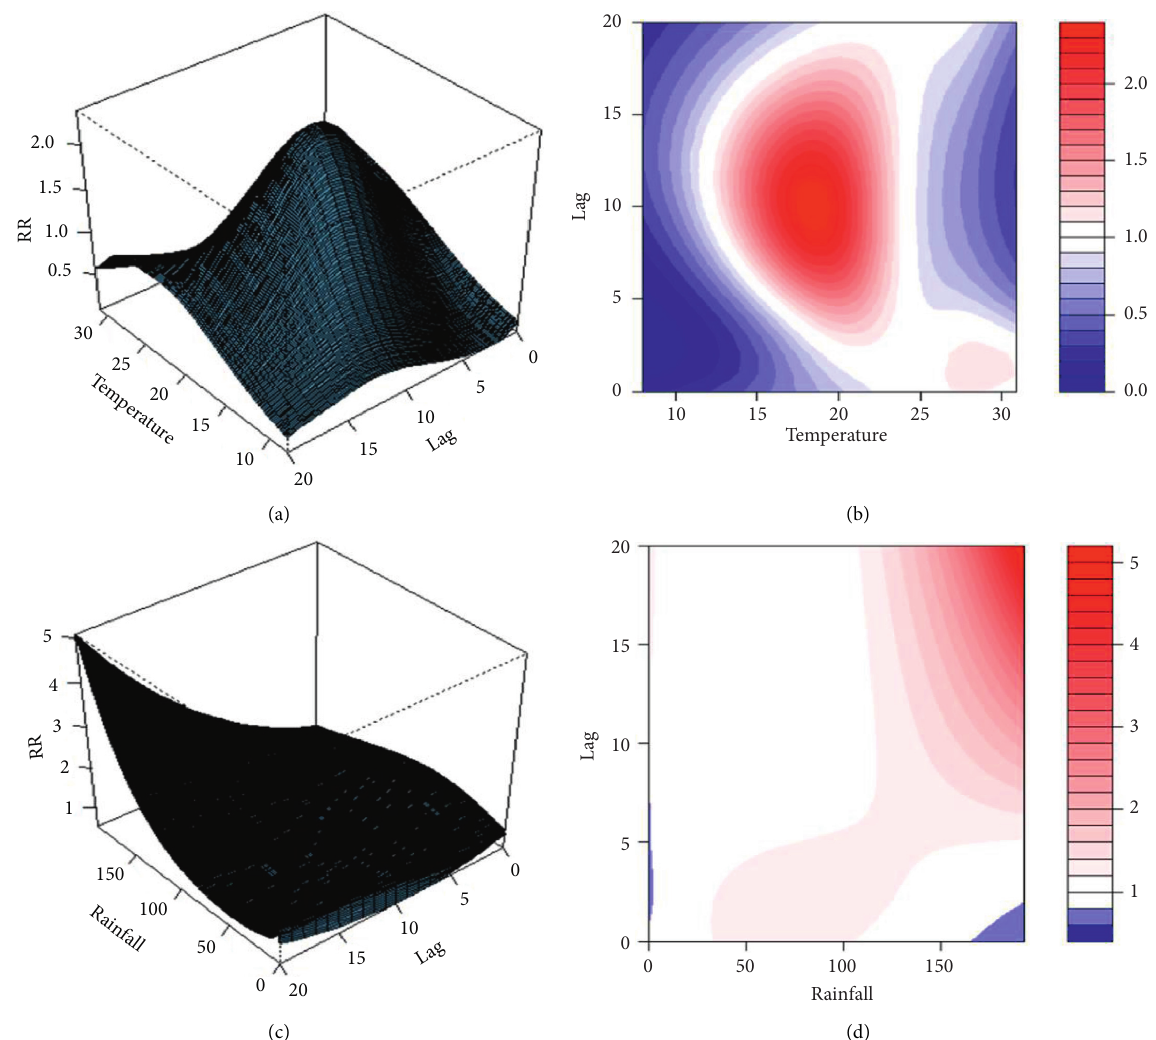
Figure 3: The three-dimensional graphs and corresponding contour plots showing the relative risk of dengue fever incidence at lagged weeks along with temperature (a), (b) and rainfall (c),